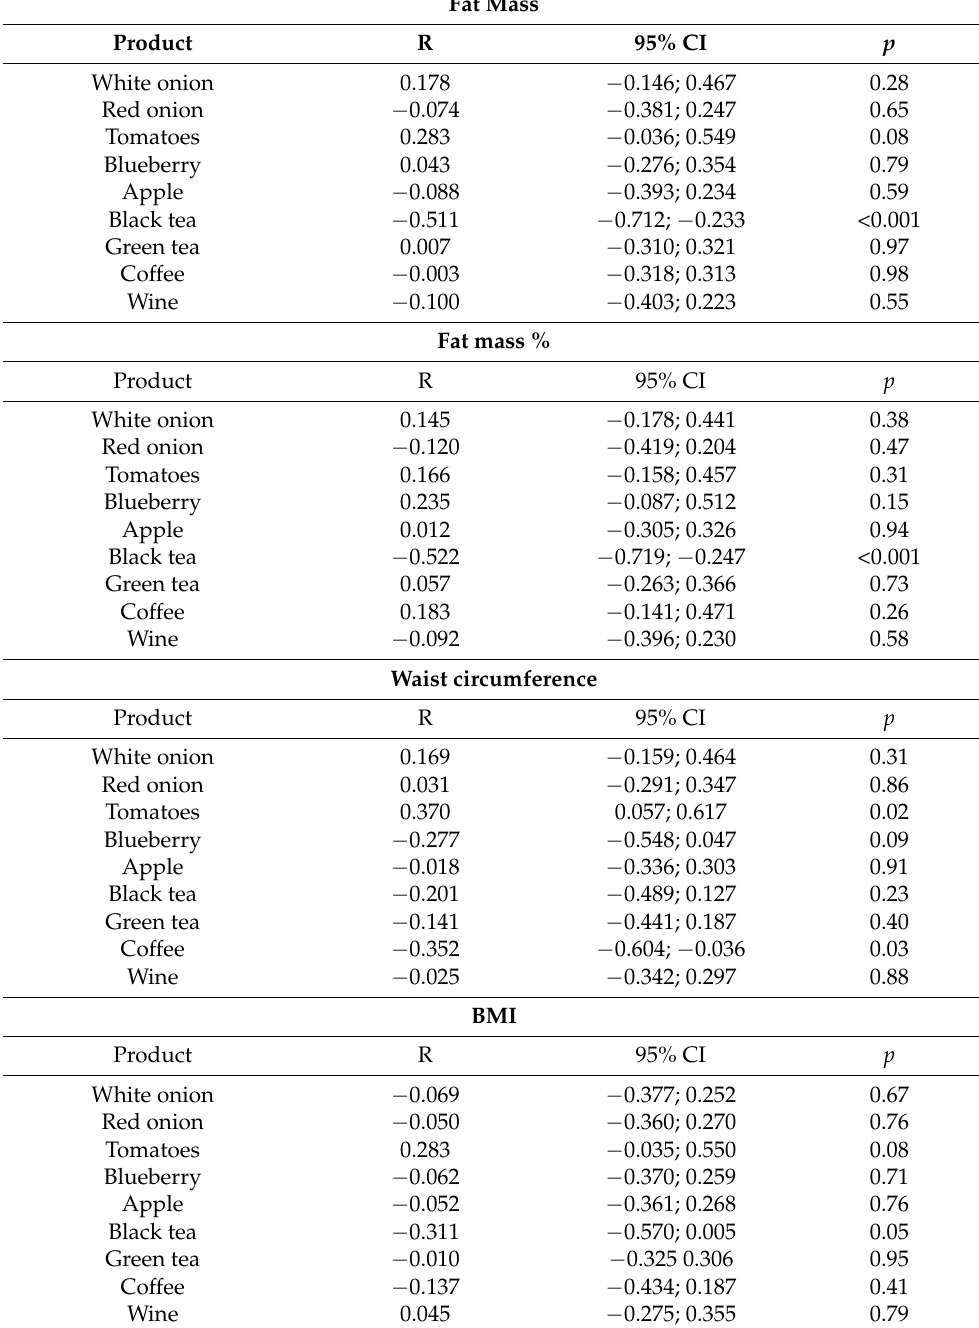
Table 5. Correlation between flavonols’ sources mean consumption and obesity assessment